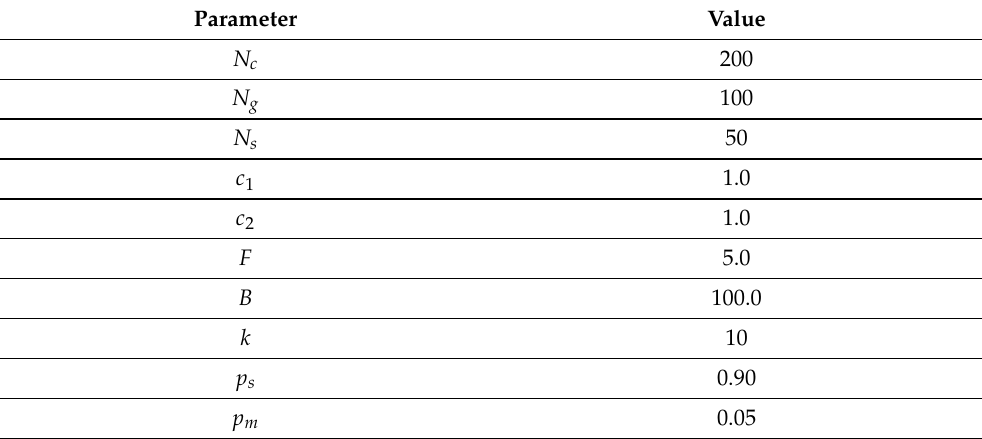
Table 1. The used values for the experimental parameters. The first column denotes the name of the parameter and the second the used value.